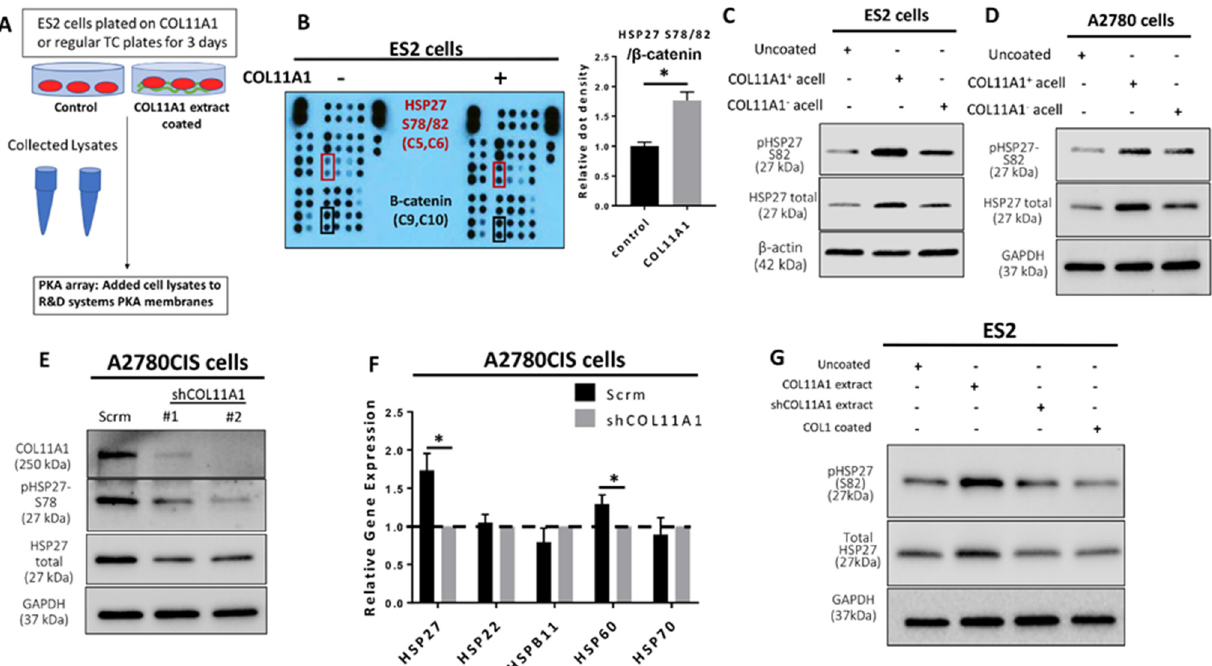
Figure 1. COL11A1 induces HSP27 phosphorylation and total expression in ovarian cancer cells. ( A ) Schematic of the Protein Kinase array (PKA) experiment set up. ( B ) Image and quantification of the PKA result. Red boxes on the image indicates the position of the HSP27 S78/82 antibody epitopes, and black boxes indicate the β -catenin epitopes. Coordinates for the HSP27 S78/82 epitopes and β -catenin on membranes are listed below the protein name in parentheses. Bar graph shows quantification of the HSP27 (S78/82) dot densities normalized to β -catenin. ( C ) Western blot of the phosphorylated (at S82) and total HSP27 in ES2 cultured on COL11A1-positive and -negative A204-derived decellularized matrices (referred to as acell) and control (uncoated) conditions. ( D ) Western blot of the phosphorylated (at S82) and total HSP27 in A2780 cells cultured on COL11A1-positive and -negative A204-derived decellularized matrices and control conditions. ( E ) Western blot of phosphorylated (at S78) and total HSP27 in A2780CIS-scrm and A2780CIS-shCOL11A1. ( F ) Gene expression of HSP27 (HSPB1), HSP22 (HSPB8), HSPB11, HSP60 (HSPD1), and HSP70 (HSPA1A) in A2780CIS-scrm and A2780CIS-shCOL11A1 measured by RT-PCR. ( G ) Western blot of the phosphorylated (at S82) and total HSP27 in ES2 cultured on COL11A1-positive and -negative extracts and control conditions ( n = 3). GAPDH and β -actin were used as the loading controls for the Western blots. All experiments were performed in the standard experiment conditions (cells cultured in the above conditions for 3 days in 1% FBS medium after overnight serum starvation). Error bars indicate the standard deviation. *, p value < 0.05. The uncropped Western blot figures are presented in Figure S5.